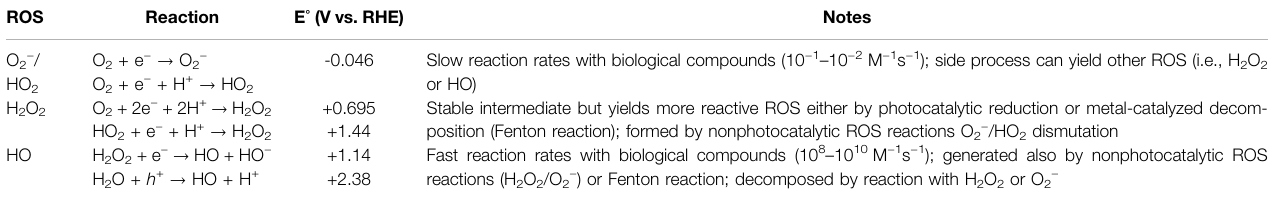
TABLE 3 | ROSgeneration reactions and other properties (Boyjooet al., 2017). Standard redox reduction potential(E ° ) is given respect to the reversiblehydrogen electrode (RHE). E ° vs. RHE (cid:1) (E ° vs. NHE) + 0.059 × pH, where NHE is the normal hydrogen electrode. ROS Reaction